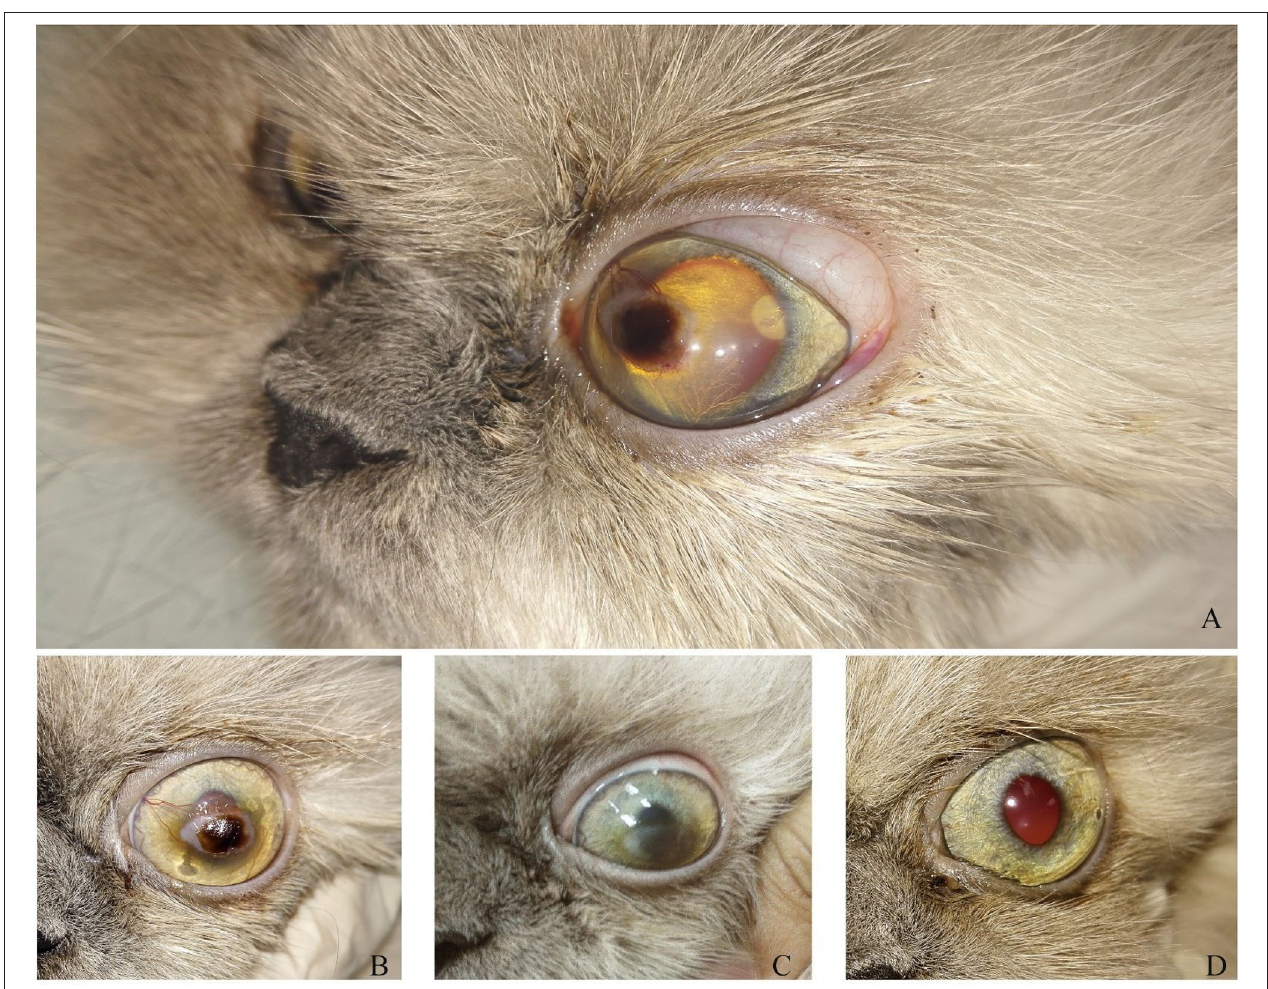
FIGURE 4 | A photography series of Himalayan cat showing (A) superficial ulcer with sequestration (B,C) reduction of corneal ulcer size after 1,2-month post-injection, respectively, (D) complete healing of ulcer after 3 months of injection.